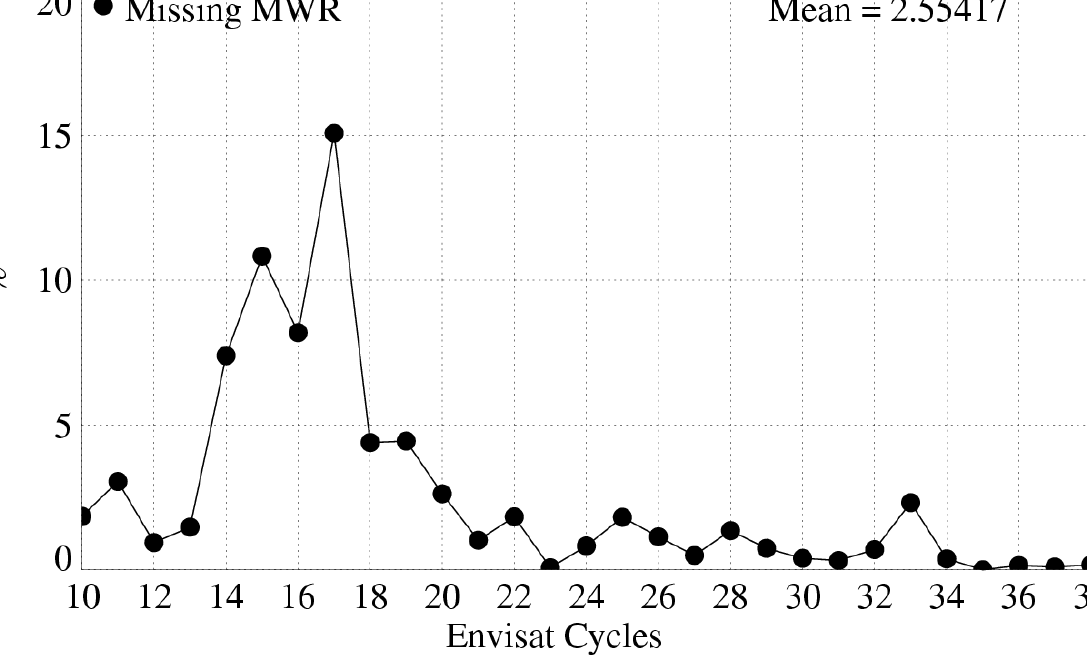
Figure 2. Cycle by cycle percentages of missing MWR